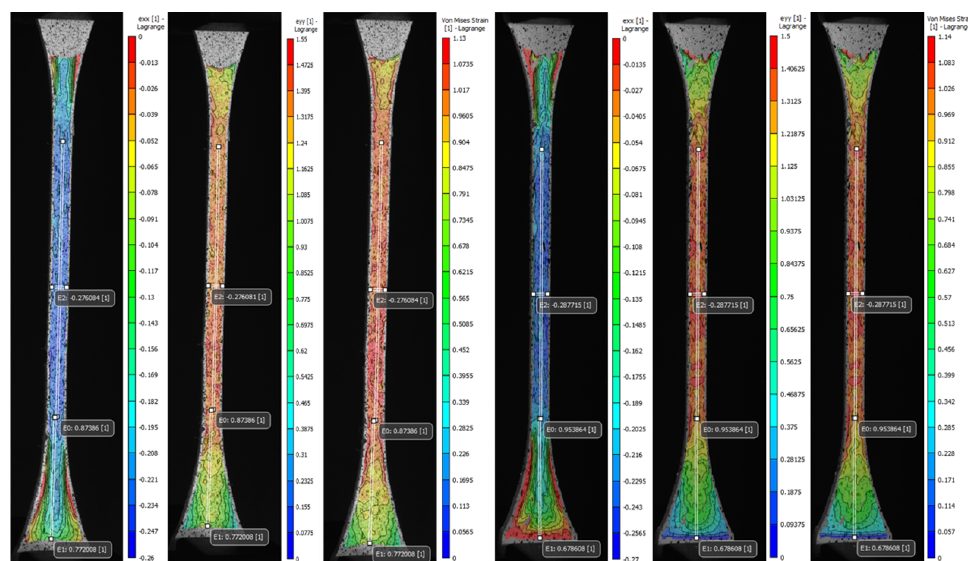
Figure 13. Digital image correlation (DIC) strain fields of the most significant specimens: V Tendon- Mimic (TM)—J1 Helix-Bamboo (HB) patterns. Longitudinal strain (e yy ), local transverse strain (e xx ), and Von Mises equivalent strain (e eq ). The virtual longitudinal extensometers E 0 and E 1 are positioned at L 0 = 33 mm (narrow section) and L = 16 mm (distal). Transverse extensometer E 2 is positioned at L = 6 mm (central).